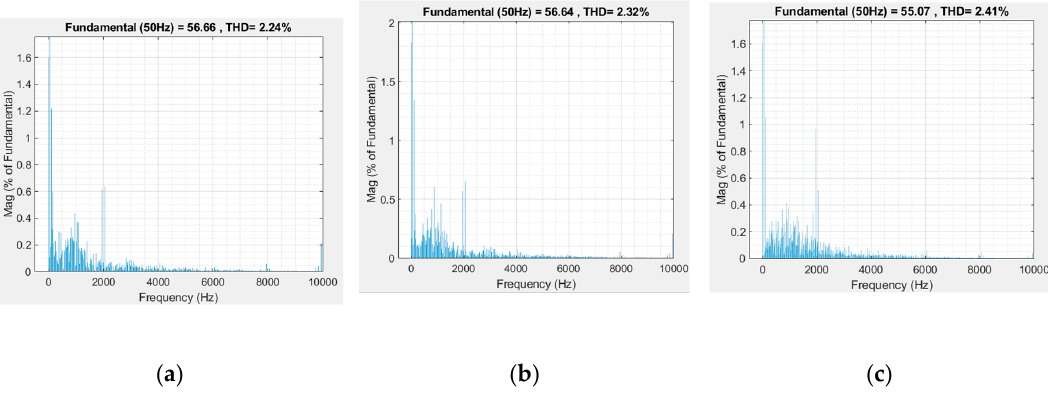
Figure 12. Grid current harmonic spectrum in inductive mode: ( a ) CHB (4000 µ F ) ; ( b ) CHB ( 1200 µ F ) ; ( c ) CHB-SDC ( 1200 µ F ) .